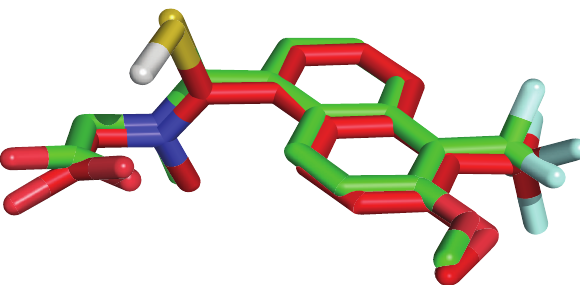
Figure 1: Superimposed view of docked pose (red) of the ALR2 inhibitor (tolrestat) with the crystal structure conformation (green) (RMSD = 0.53200